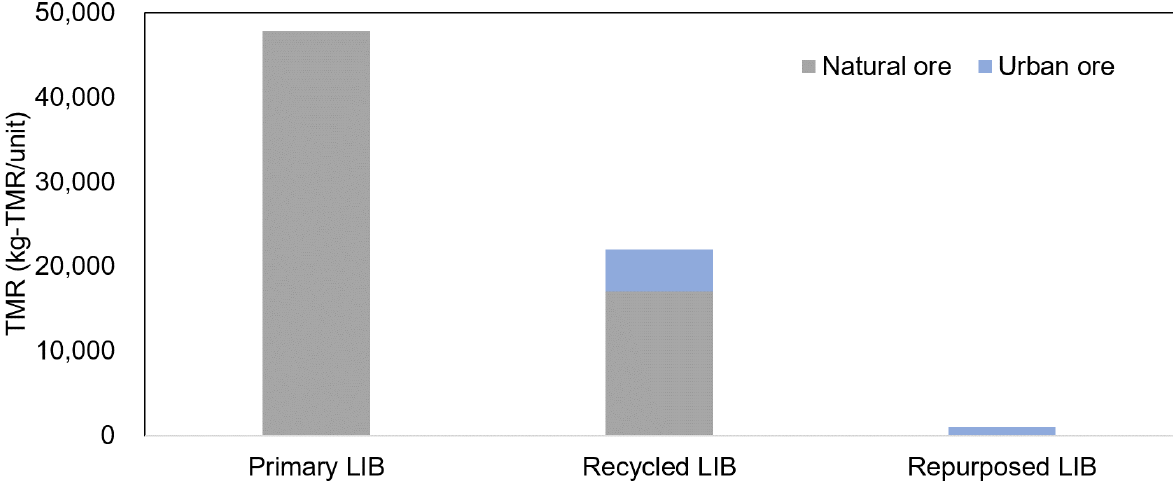
Figure 3. TMR for primary LIBs, recycled LIBs, and repurposed LIBs.